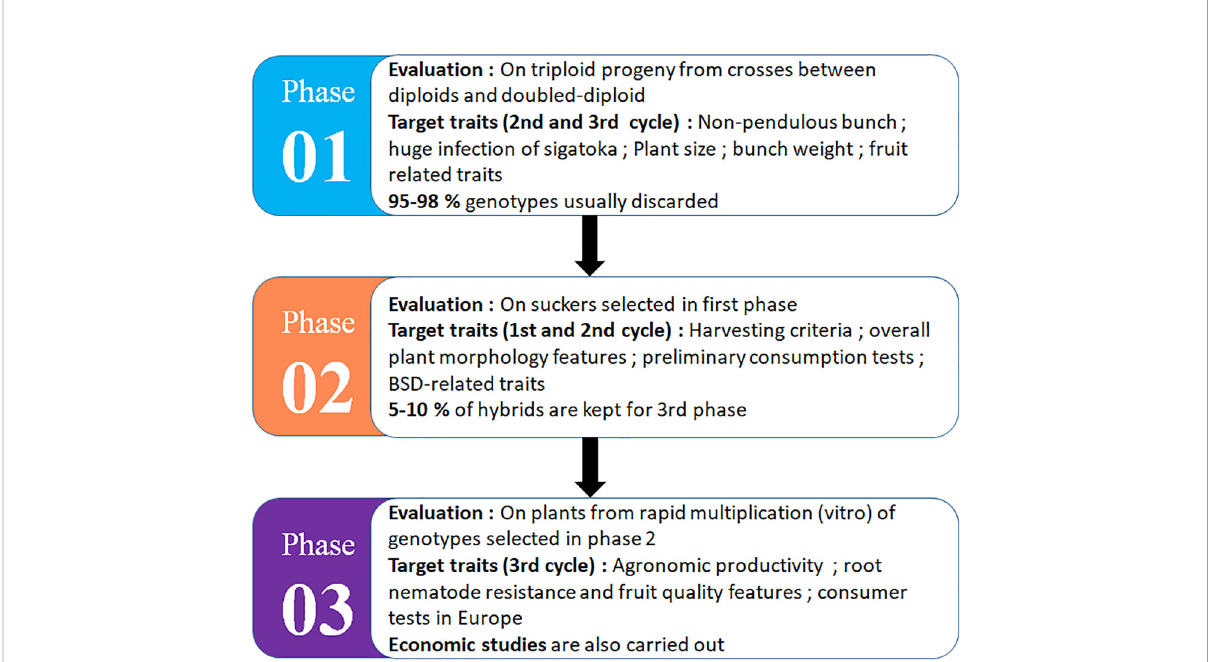
FIGURE 2 The selection process for triploid dessert export bananas by CIRAD in Guadeloupe [inspired by Bakry et al. (2009)]. The selection cycle can vary from 12 to 15 years depending on the production cycle of the variety: Phase 01 (3 – 4.5 years), Phase 02 (2 – 3 years), and Phase 03 (3 – 4.5 years) for agronomic evaluation, plus consumer test and economic impact